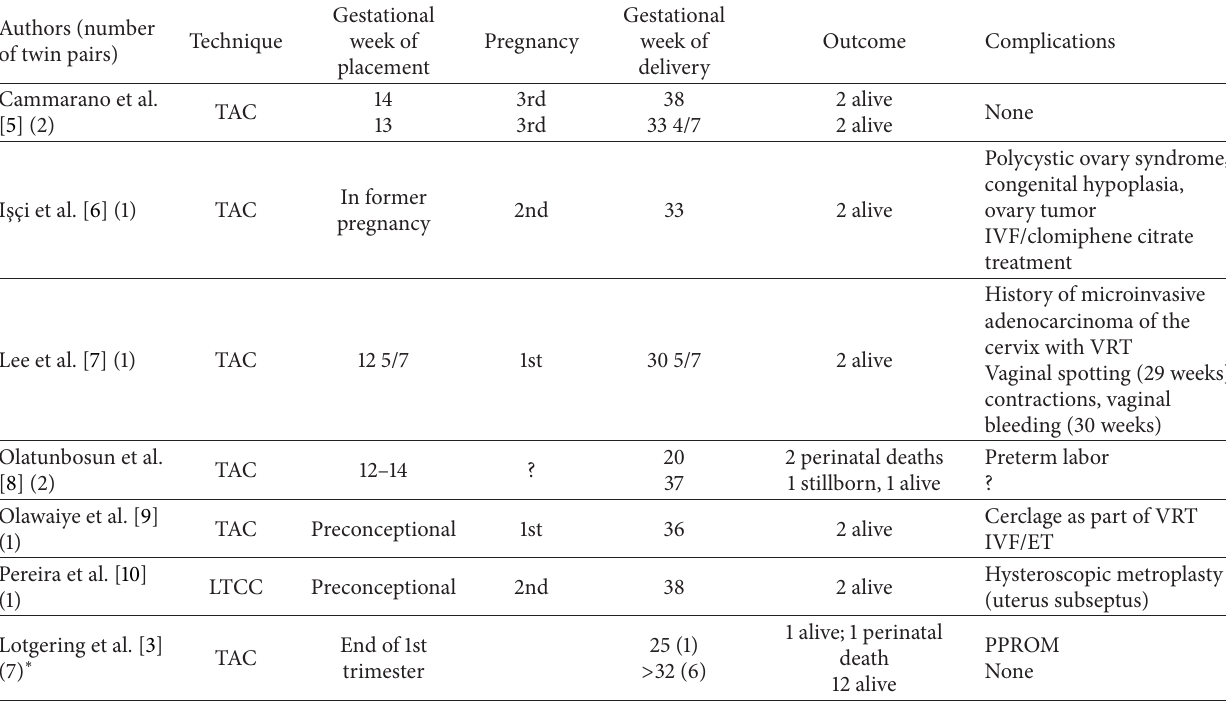
Table 1: Summary of publications on transabdominal cerclage in twin pregnancies.